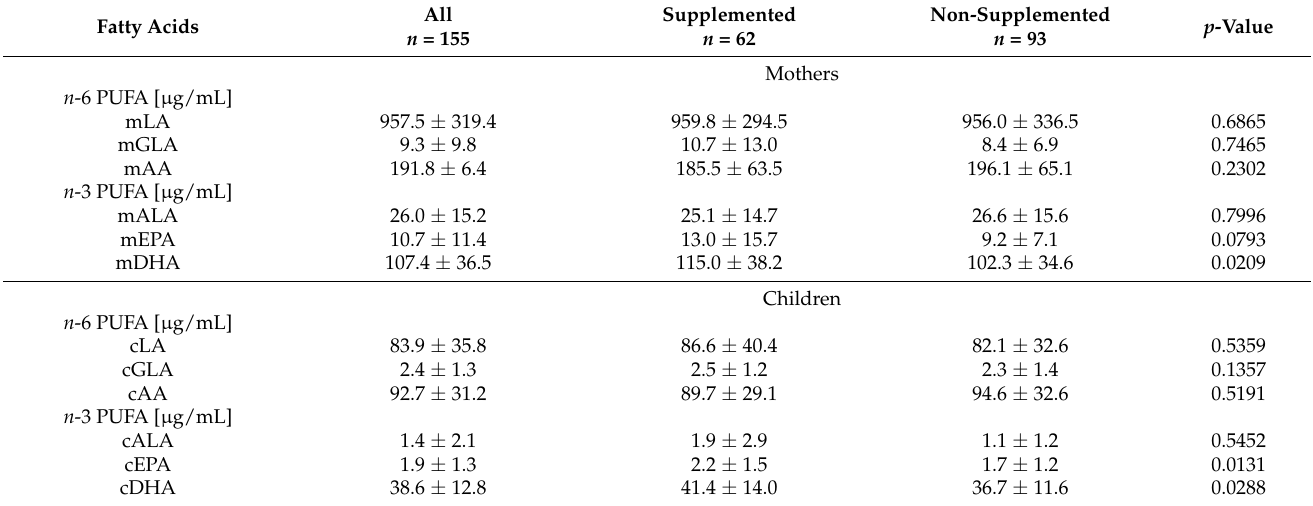
Table 3. Fatty acid content in serum samples of mothers and